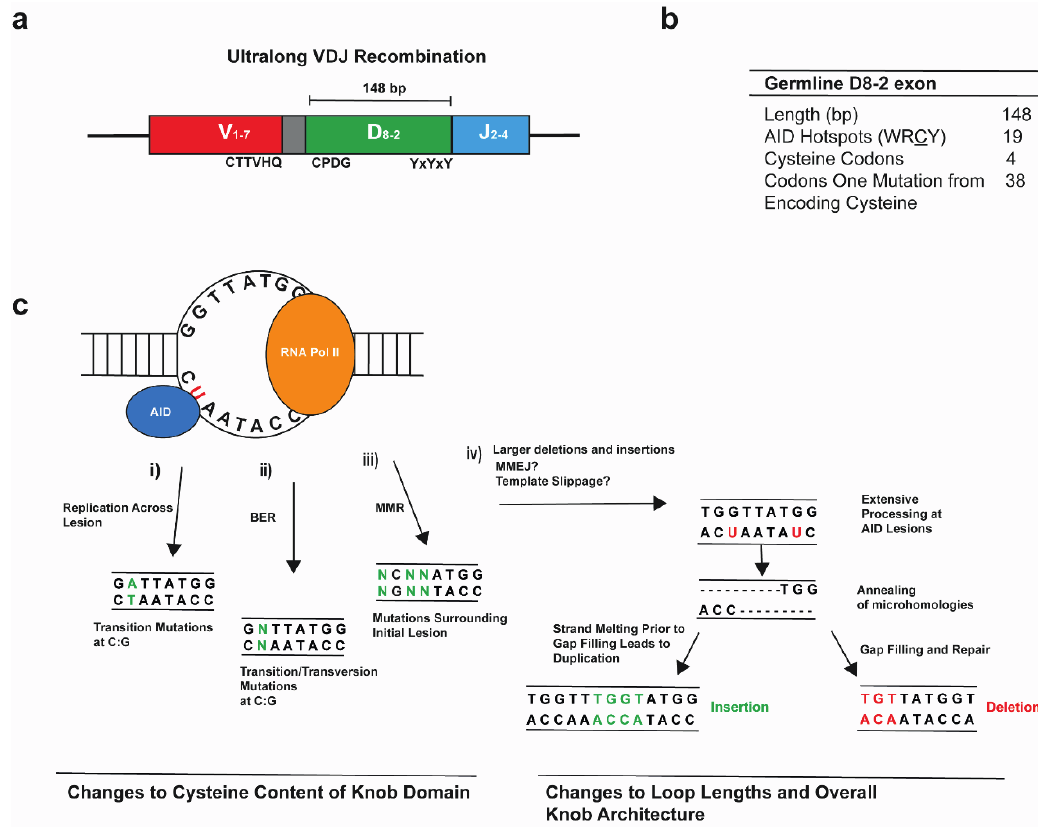
Figure 2. A single recombined variable exon is diversified to generate the ultralong repertoire in cows. ( a ) A schematic depicting the variable exon that encodes the ultralong CDR H3 of bovine antibodies. Conserved amino acids seen in the mature antibodies are indicated beneath the schematic. ( b ) The germline D8-2 gene segment encodes only four cysteines across its 148 bp sequence. However, the high density of putative activation-induced cytosine deaminase (AID) hotspots, and the large fraction of codons only a point mutation away from encoding cysteine, allow for the facile generation of cysteine codons during somatic hypermutation. ( c ) AID mechanisms of mutation. Green nucleotides indicate mutations; (i) deamination of cytosines to uracil can induce a mutation at C:G base pairs during replication; (ii) during base excision repair (BER), uracil DNA glycosylase can remove the uracil, creating an abasic site to induce mutation to any nucleotide following error-prone trans-lesion synthesis; (iii) base pairs surrounding the initial lesion can also be mutated in a process dependent upon mismatch repair (MMR); and (iv) large deletions and insertions occur in the bovine D8-2 exon. These may be the result of errors during replication across the AID-induced lesions due to template slippage or the error-prone end joining of AID-induced breaks (the latter outcomes are